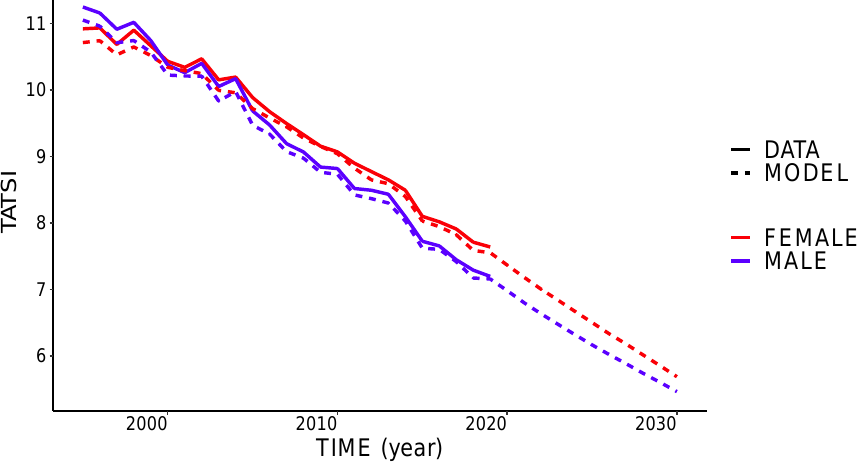
Figure 10. Projected TATSI index for female and male Italian population aged 65 from 2020 to 2030. Source: author’s own elaboration on data from ISTAT.